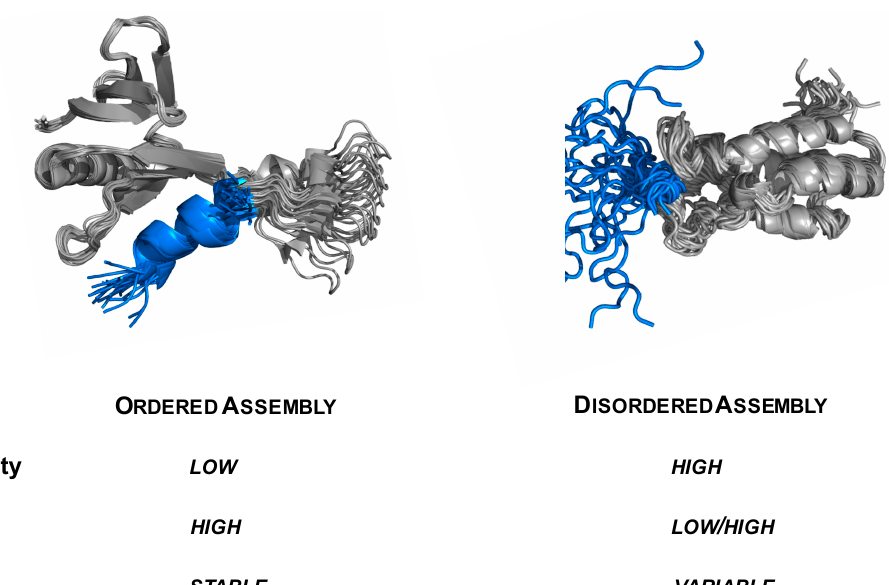
Figure 1. Characteristics of ordered and disordered assemblies. The ordered/disordered nature of a protein complex can be evaluated based on conformational heterogeneity and contact pattern variability. The frequency of contacts can be high in both cases. The ordered complex is represented by the amino-terminal transactivation domain (TAD) of the tumor suppressor p53; p53 (residues 47–55, blue) specifically binds pleckstrin homology (PH) domain (gray) of the Tfb1 subunit of TFIIH (PDB:2gs0 [16]). Upon binding, the disordered transactivator region of p53 forms an amphipathic alpha helix (blue). The disordered complex is represented by binding of the p53 disordered region following the oligomerisation domain (367–386 residues, blue) to the bromo domain (gray) of the transcriptional coactivator CBP (CREB binding protein). However, in the complex structure (PDB:1jsp [17]) the p53 region partly folds, it does not adopt a stable structure; instead, partly remains disordered in the bound state.